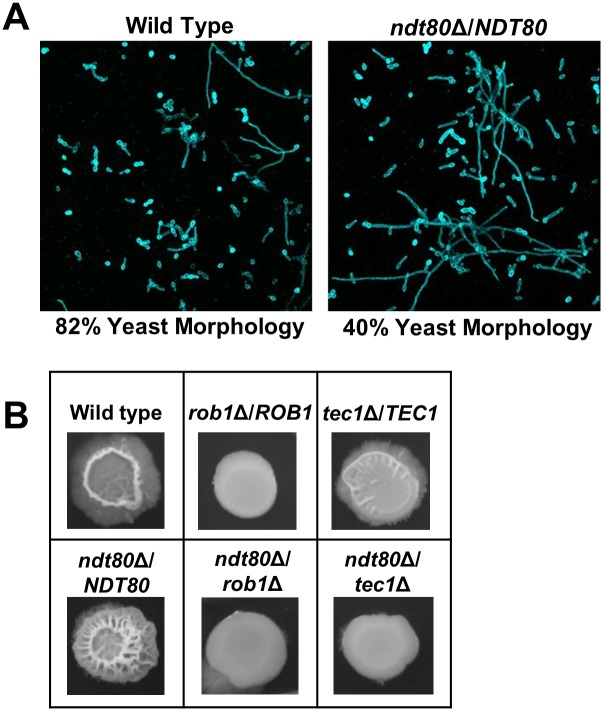
The basal layer of the ndt80Δ/NDT80 biofilm has an increasaed proportion of filaments relative to WT.(A) High magnification view of biofilm centered at 30 nm from solid surface. The relative proportion of yeast and filamentous cells (hyphae+pseudohyphae) was based on counting at least 100 total cells for the two strains. (B) The indicated strains were spotted on Spider medium and incubated at 37°C before the photographs were taken.